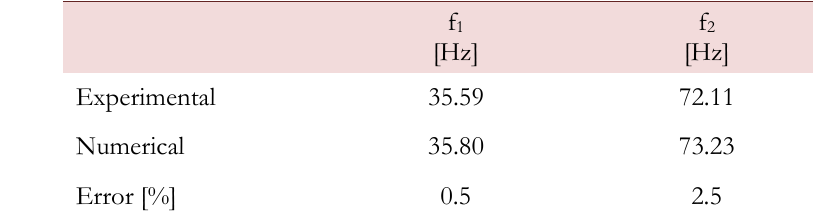
Figure 1: Geometry of the masonry arch.